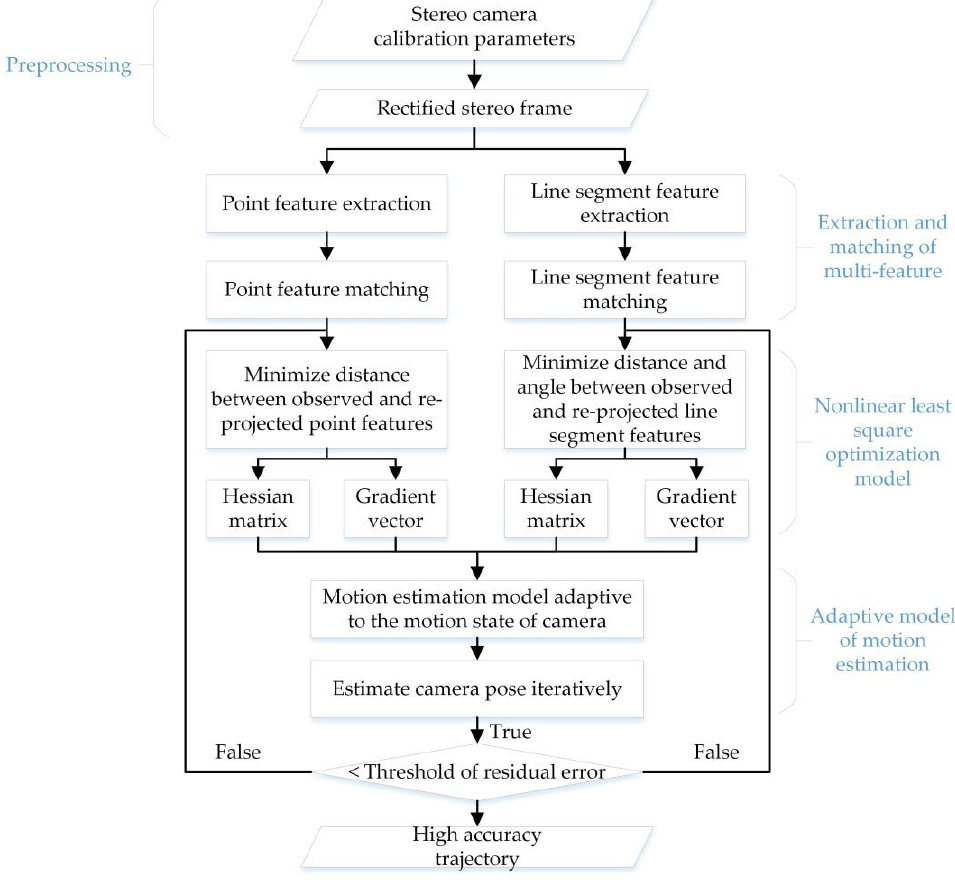
Figure 1. Flowchart of our proposed visual SLAM